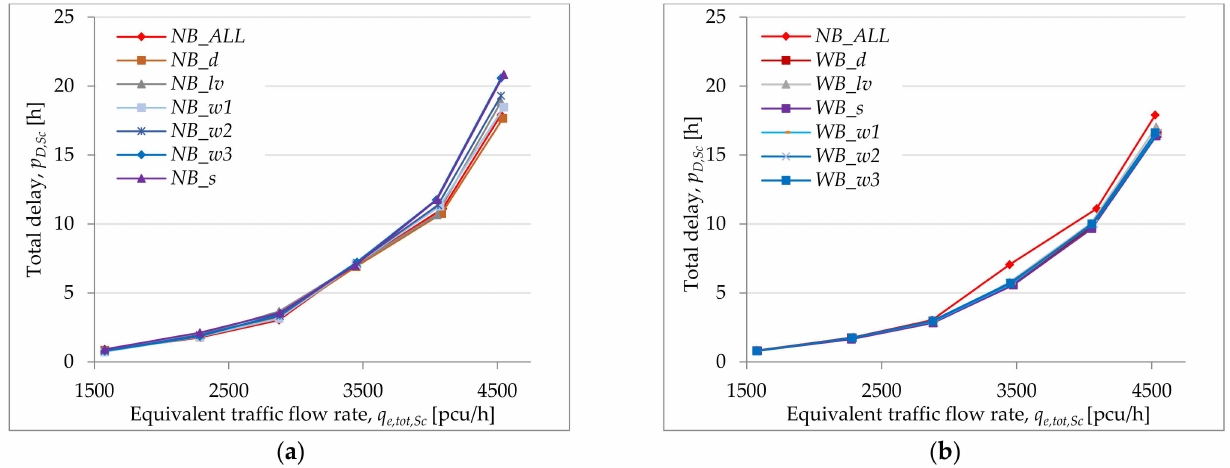
Figure 8. Simulated total delays of all vehicles as a function of total equivalent traffic flow rate: ( a ) for NB_ALL , NB_c scenarios; ( b ) for NB_ALL , WB_c